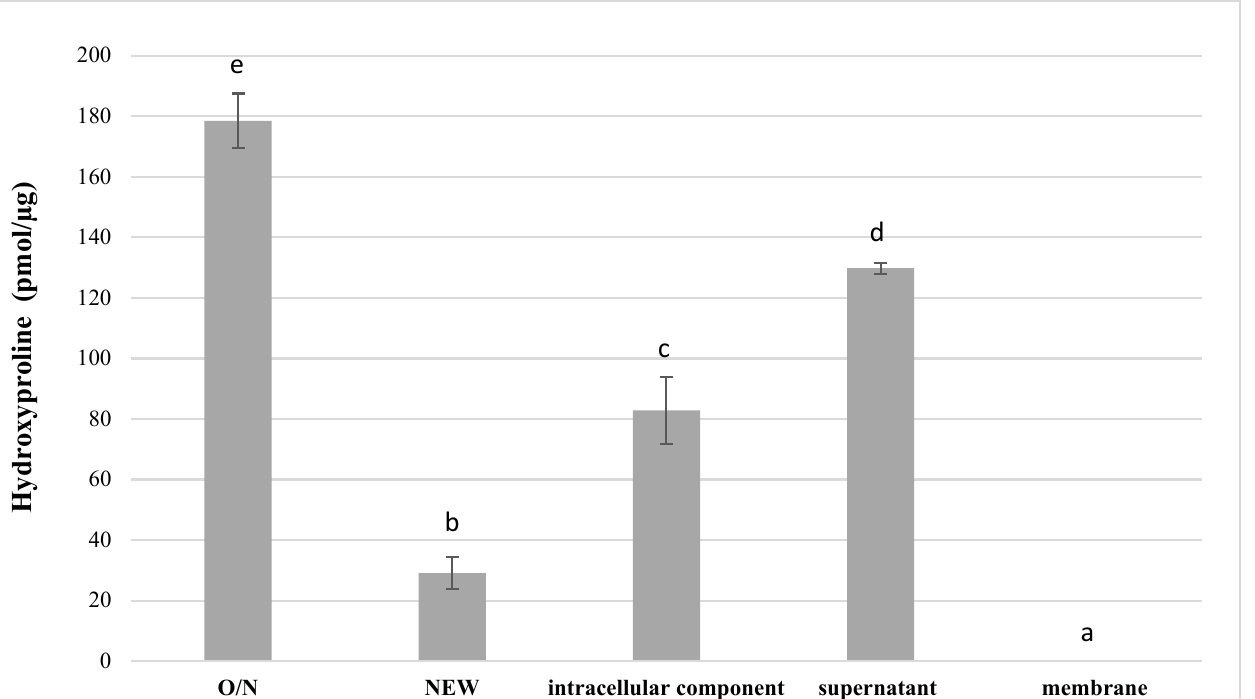
Figure 3. Hydroxyproline released into media after incubation of dentinal collagen slabs with O/N and NEW S. mutans UA159 and its discrete fractions (n = 3; data are reported as mean ± standard errors). Different lowercase letters indicate statistically significant differences between the groups. Values with the same letters indicate non-significant differences ( p >